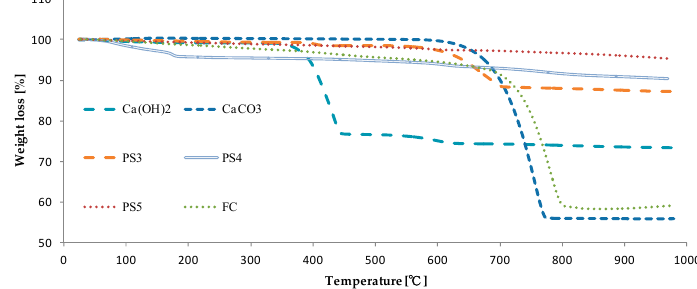
Figure 4. XRD Patterns of several calcium compounds and additives. TG was performed on Ca(OH) 2 and CaCO 3 of 99.9% purity to confirm that the two weight losses in the TG curve of additives were due to the thermal decomposition of Ca(OH) 2 and CaCO 3 . Figure 3 compares the TG curves of each calcium compound and the additives. The TG analysis of Ca(OH) 2 , CaCO 3 , and additives was conducted under a nitrogen atmosphere based on the methods decribed in References [25,26]. Based on previous study, Ca(OH) 2 was thermally decomposed at 330–460 °C into CaO [26], and CaCO 3 was thermally decomposed into CaO at around 700 °C [27]. As seen in Figure 3, the weight losses in PS Ash 3 at around 390 °C and 600 °C corresponded to the thermal decompositions of Ca(OH) 2 , and CaCO 3 . The weight losses in PS Ash 4 (around 600 °C), PS Ash 5 (around 590 °C), and FC (around 700 °C) corresponded to the thermal decomposition of CaCO 3 . From these results, it was found that the Ca(OH) 2 and CaCO 3 in additives could be detected by TG. Since the decomposition temperature of CaO is above 1000 °C [25] and cannot be detected by TG, the analysis of calcium compounds in the additives was performed using the XRD method. Figure 4 shows the X-ray diffraction patterns of several calcium compounds and additives. All of the peaks in the additives were compared with the peaks in each calcium compound. The results showed that PS Ash 3 contained CaCO 3 , CaO, and Ca(OH) 2 ; PS Ash 4 and PS Ash 5 contained small